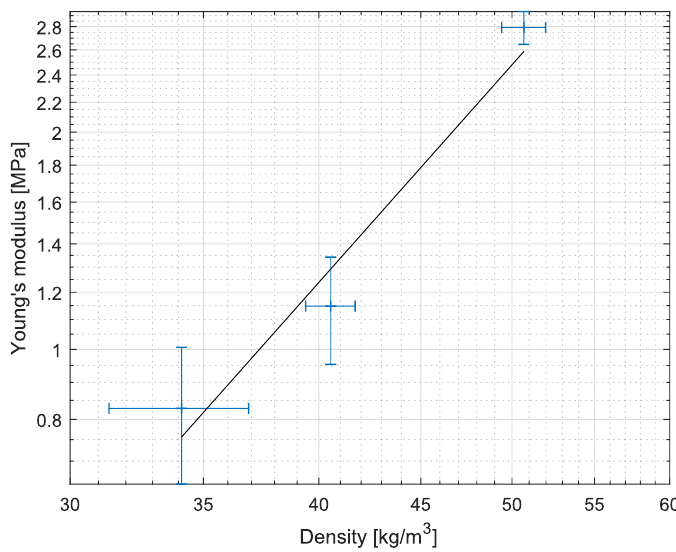
Figure 2. Dependency of Young’s modulus on material density.